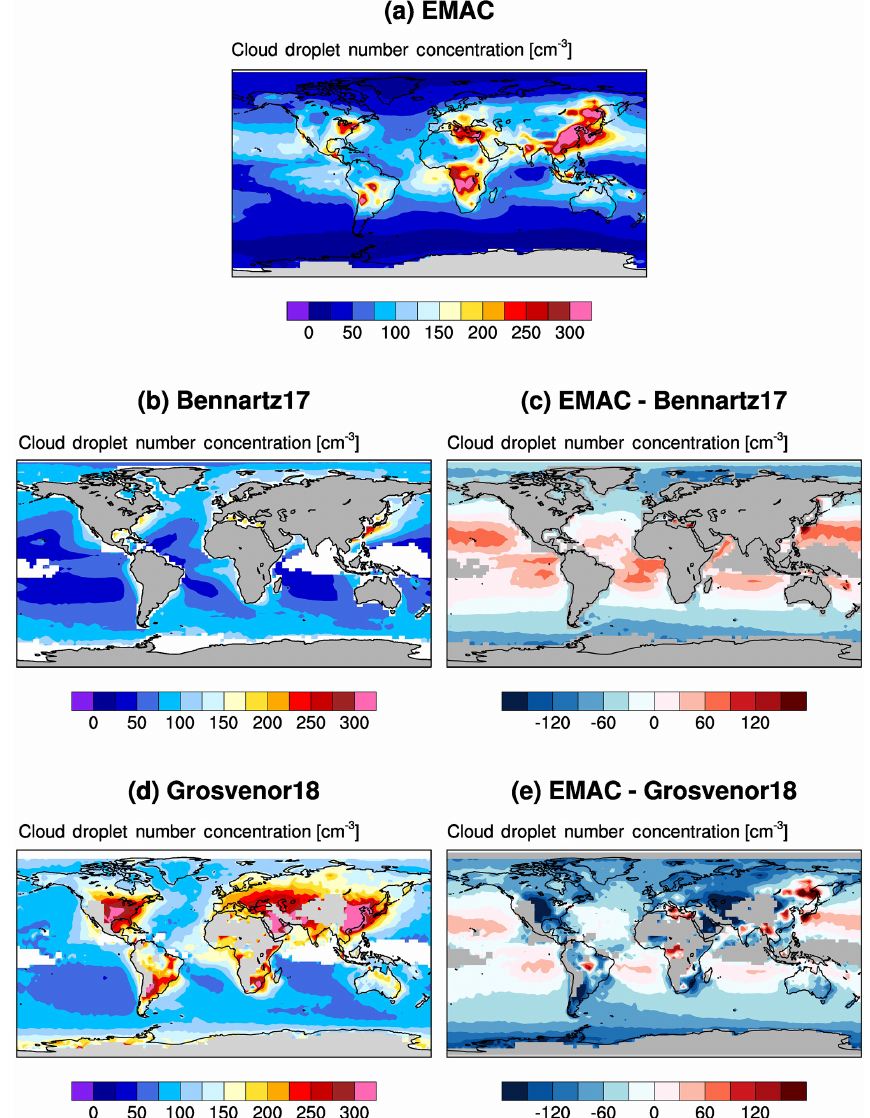
Figure 4. Multi-year (1996–2005) average of CDNC at cloud top, as simulated by EMAC (a) and observed by two satellite retrievals (b, d) , as well as the difference between model and observations (c, e)